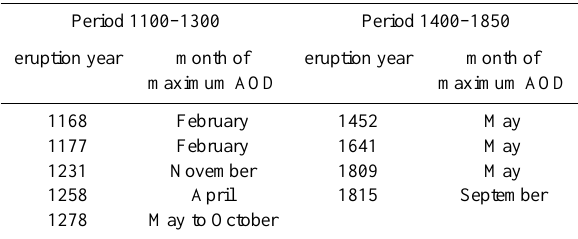
Table 1. Month of maximum global mean AOD for the selected eruptions. The input time series is based on the monthly mean op- tical thickness latitudinal reconstruction by Ammann et al. (2003) and Gao et al.